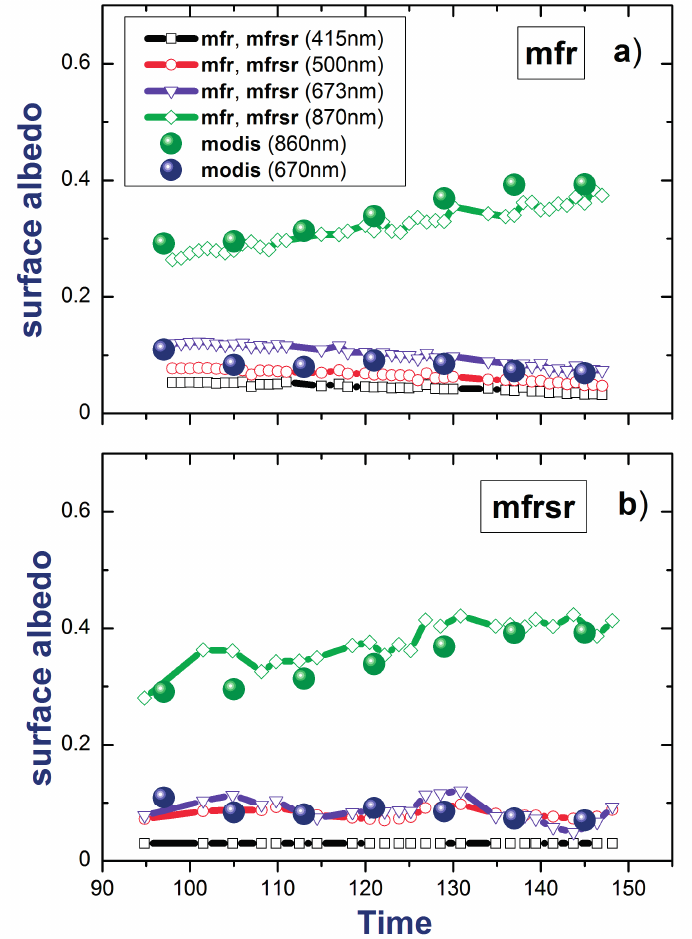
Figure 3. Time series of the ( a ) tower-measured local and ( b ) MFRSR-retrieved areal-averaged surface albedo at the NOAA site during the two-month period (April–May 2010). Here time is day of year. Black, red, purple and green colors define the surface albedo values at four wavelengths (415, 500, 673 and 870 nm). Also, the MODIS-derived surface albedo values at two wavelengths (670 and 860 nm) are included (blue, green